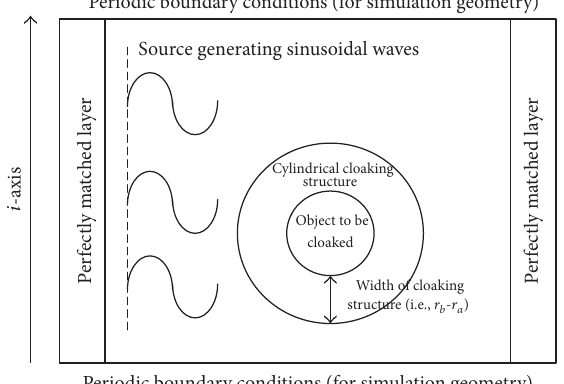
Figure 2: Simulation geometry for FDTD method of cloaking [10,